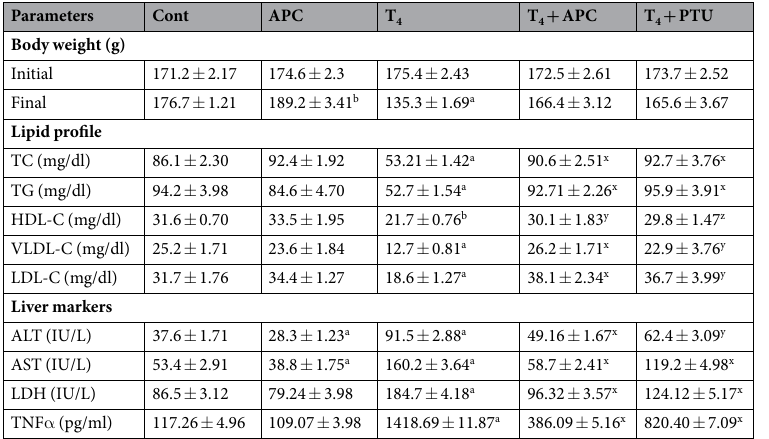
Parameters Cont APC T 4 T 4 + APC T 4 + PTU Body weight (g)